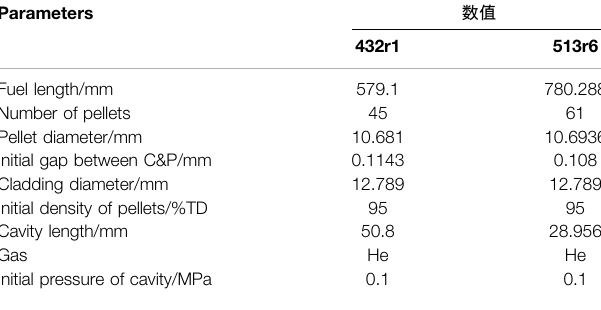
TABLE 3 | Experimental model parameters of the IFA-432r1 、